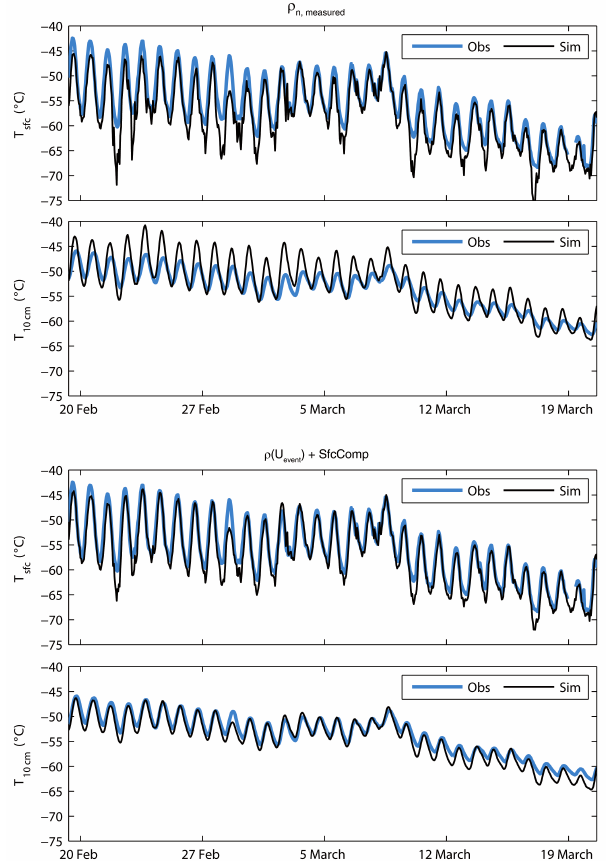
Fig. 6. Observed (Obs) and simulated (Sim) snow surface tem- perature T sfc and snow temperature T 10cm at 10-cm depth, 19 February–20 March 2008. The two upper panels relate to the simulation “ ρ n , measured ”, the two lower ones to the event-driven simulation ” ρ(U event ) + SfcComp”, that is, with additional wind densification at the